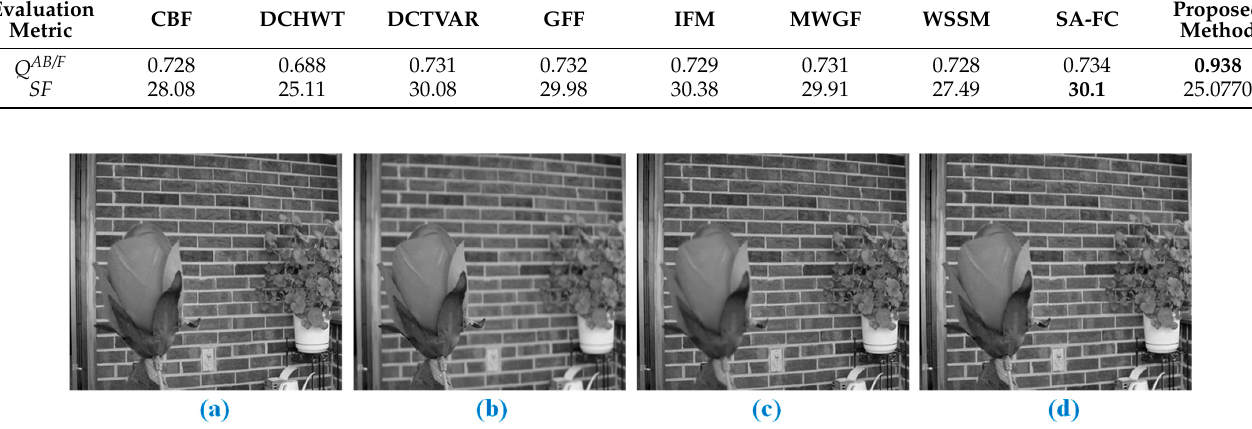
Figure 12. (Flower): ( a ) original image; ( b , c ) multi-focus input images; and ( d ) proposed fusion. Table 22. The outcomes for the flower image and comparisons with existing techniques in the liter- ature ([21]).